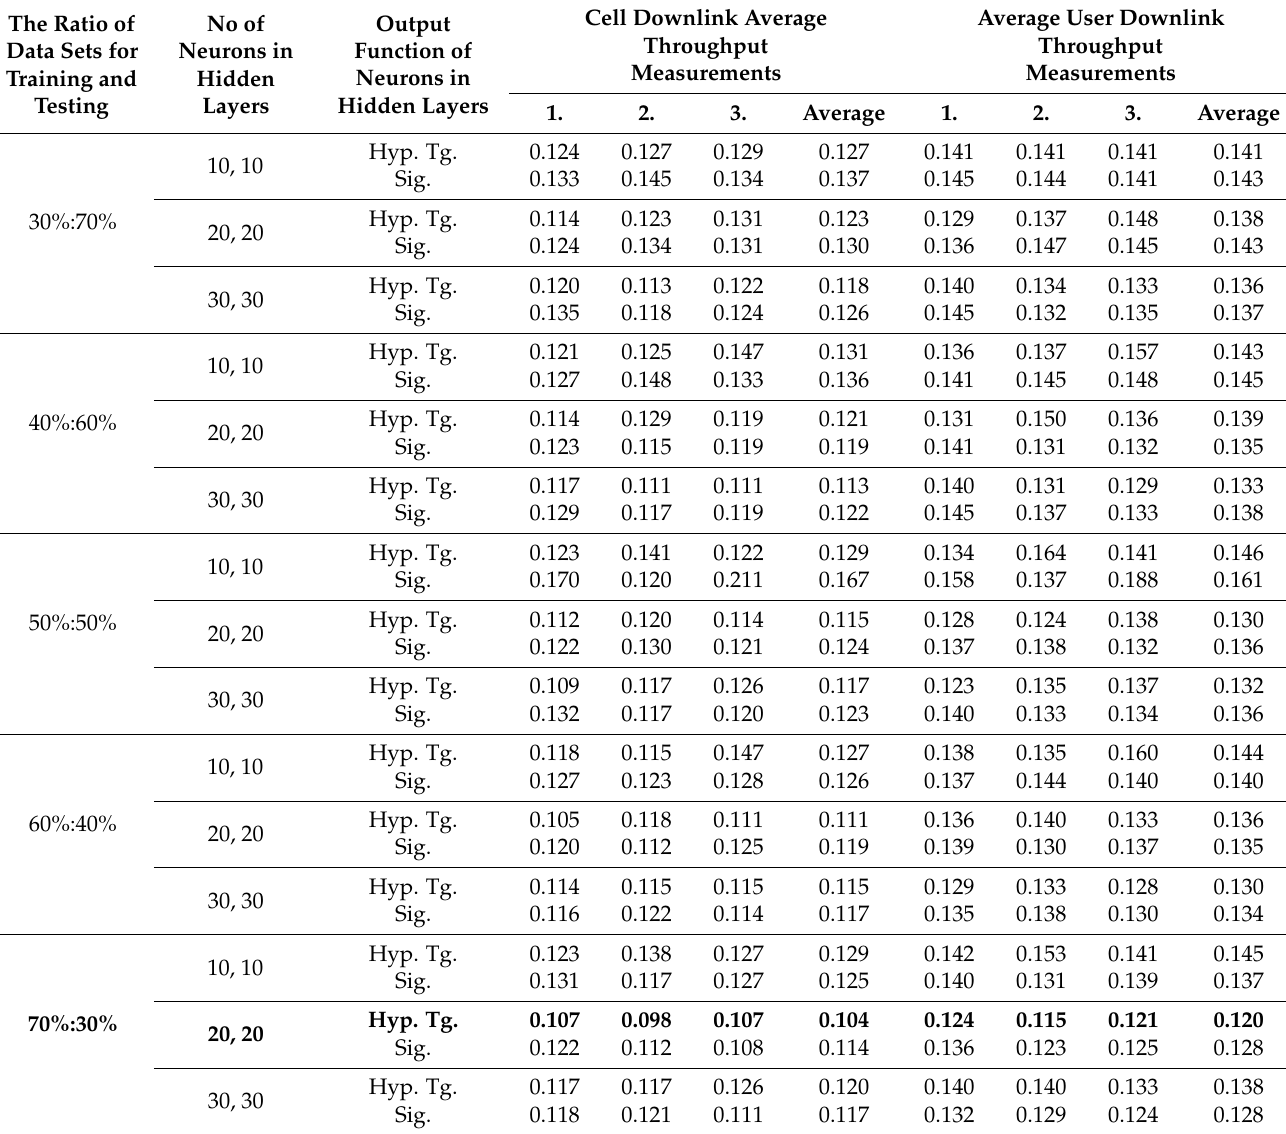
Table 7. Relative testing errors of the tested